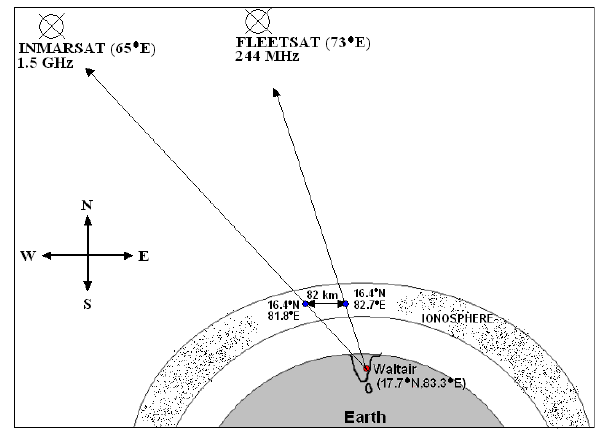
Fig. 3. Geometry of the signal paths from the two geostationary satellites (FLEETSAT, 73 ◦ E and INMARSAT, 65 ◦ E) to the receiv- ing station at Waltair.